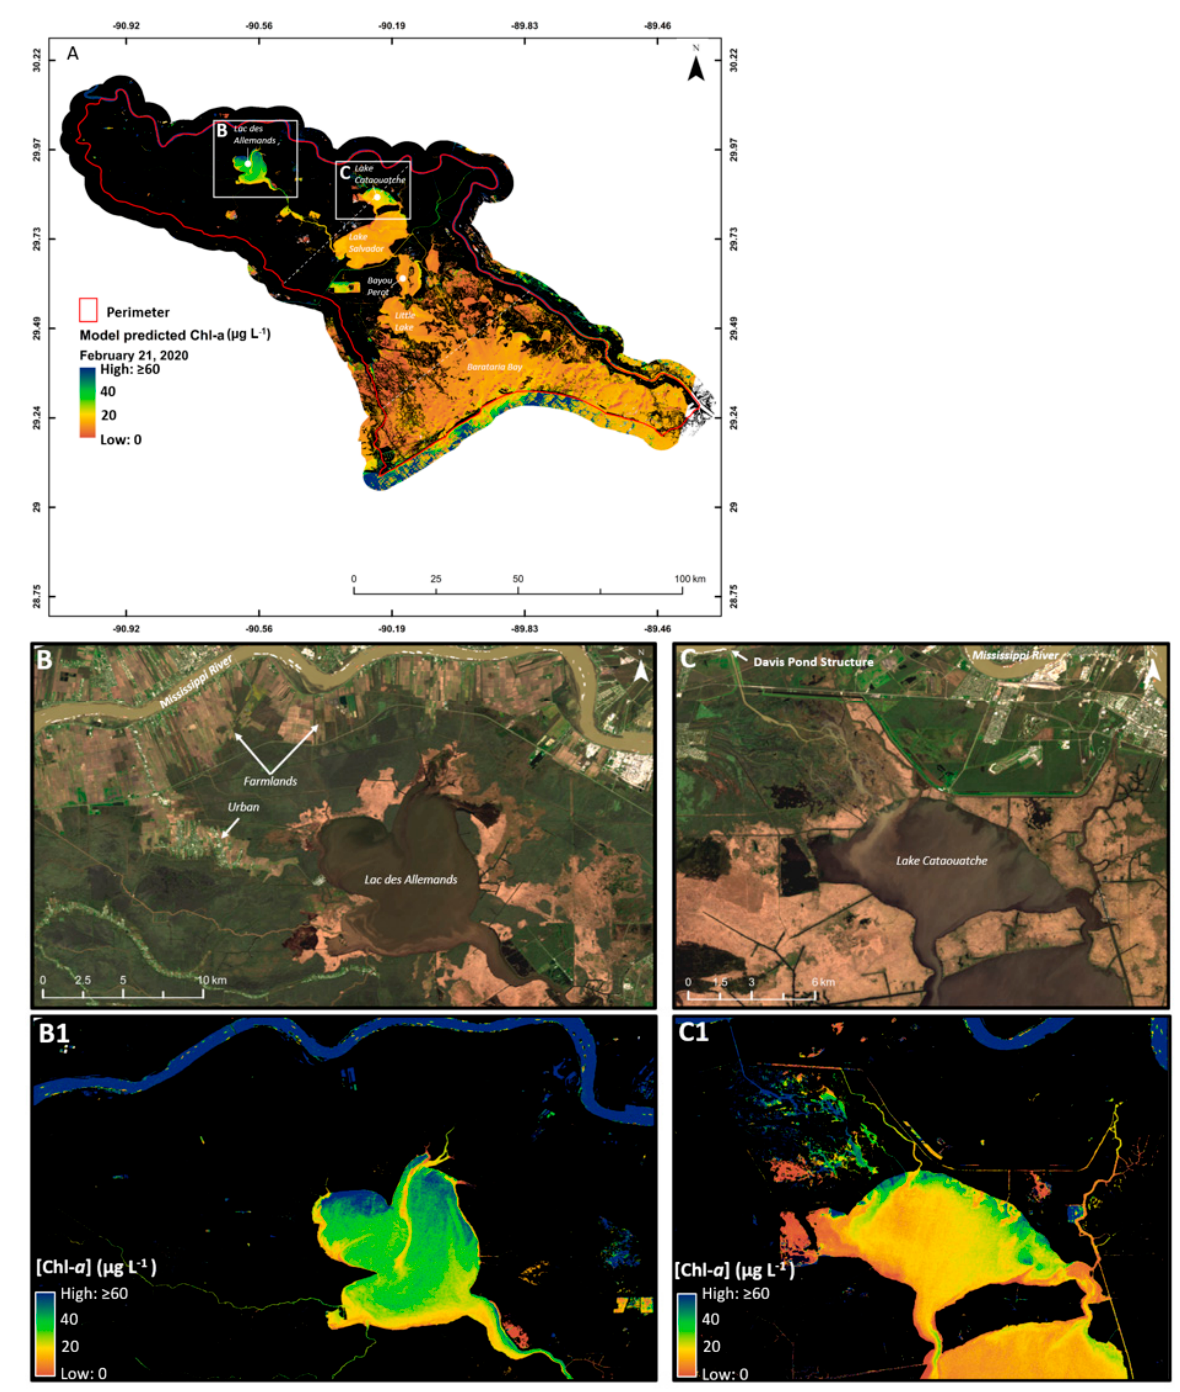
Figure 11. Landsat 8/OLI satellite image 21 February 2020. ( A ) Spatial distribution of Chl- a estimated using the exponential model between continuous in situ Chl- a and the R t ratio (B1 + B4)/B3 in the BB complex. Dotted lines indicate the delimitation between the upper, middle, and lower basins. ( B ) and ( C ) are Landsat 8/OLI satellite images natural color, while B1 and C1 are processed images showing Chl- a spatial distribution in Lac des Allemands and Lake Cataouatche (see Figure 1 for lake locations in the BB complex).